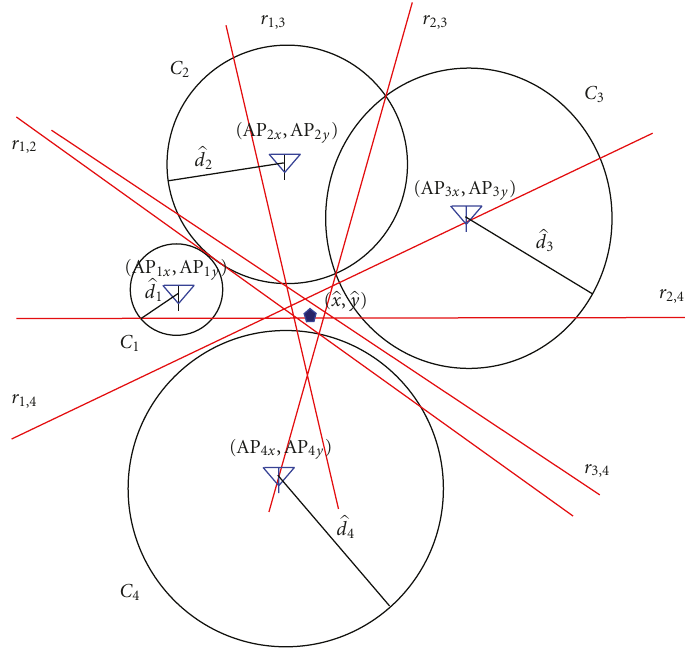
Figure 6: Least-squares solution of the six radical axes that correspond to four circles.